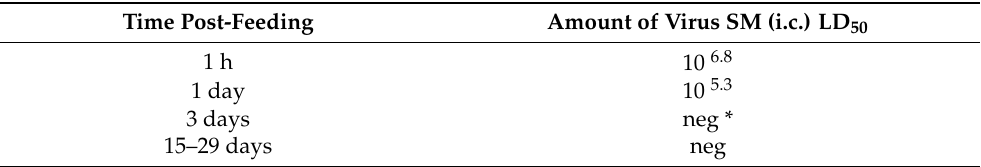
Table 3. Amount of virus in pools of three cimicid bugs at different times after an infectious blood meal with KKV .